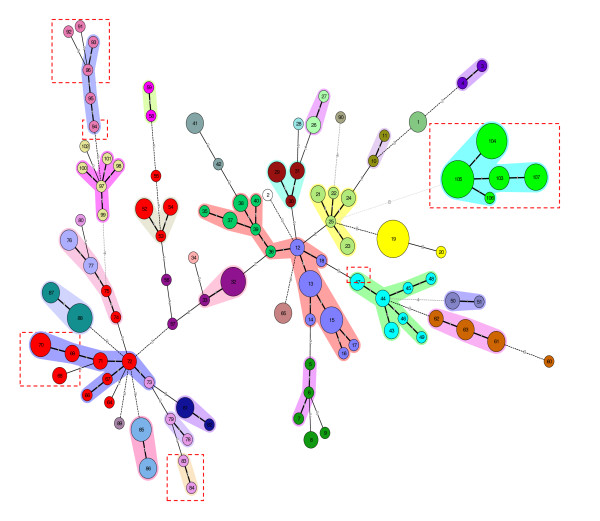
Minimum spanning trees obtained using 11 markers for the polymorphism profile of 206 Salmonella enterica subspecies strains discriminated into 107 MLVA types. The MST construction was made using the categorical coefficient. Each circle represents a different MLVA type. Each serovar is shaded with a different color. The size of the circle reflects the number of isolates whereas the distance between the circles represents the genetic divergence (heavy short lines connect SLVs, thin long lines connect DLVs, and dotted lines indicate the connection between 2 allelic distribution types). The number in each circle indicates the genotype. Red dotted squares indicate human isolates. The halos surrounding the various types denote the groupings obtained by Bionumerics analysis. In Bionumerics MLVA clonal complexes are grouping genotypes different by one allele.